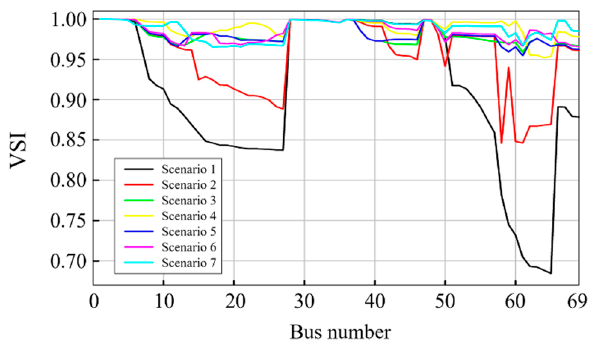
Figure 7. A comparison of VSI at each bus of 69-bus system for seven scenarios performed by proposed ASFLA.